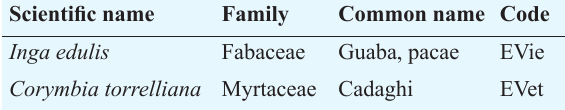
Table 1. Forest species used in the trials